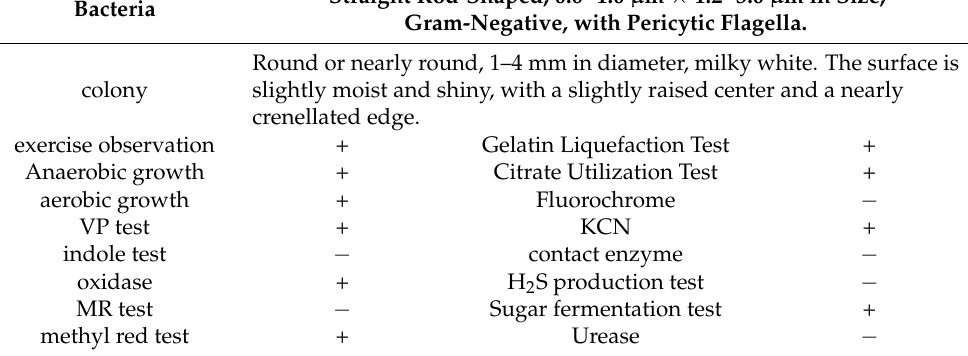
Table 1. Morphological, physiological, and biochemical characteristics of MX1 (Note: “+” means positive, “ − ” means